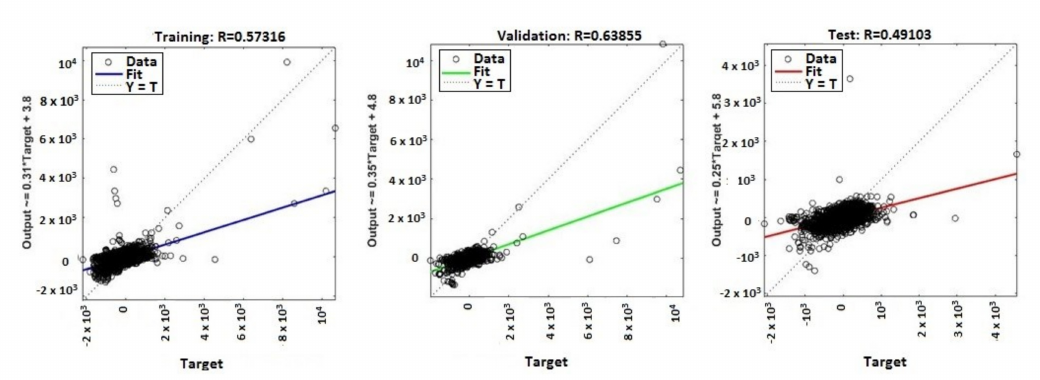
Figure 9. Regression ( R 2 ) for validation, test, and training—ANN with ten neurons.